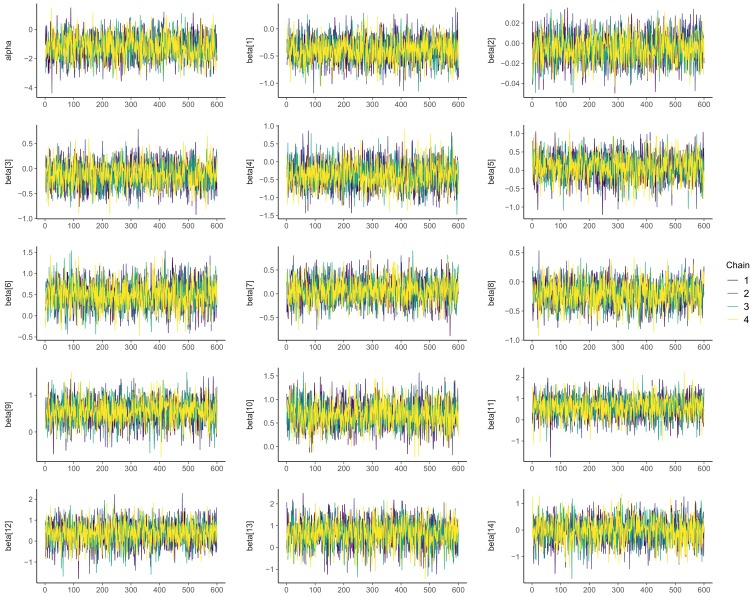
Posterior chains from Hamiltonian Markov chain Monte Carlo fitting using Stan for risk factor model A (see Table 2).The parameters are the intercept [alpha] and 14 slopes for covariates [betas]. The Gelman-Rubin diagnostic (R^) is <1.01 for all parameters. The tail effective sample size (ESStail) ranges from 1948 to 2499 and the bulk effective sample size (ESSbulk) ranges from 1808 to 2350.